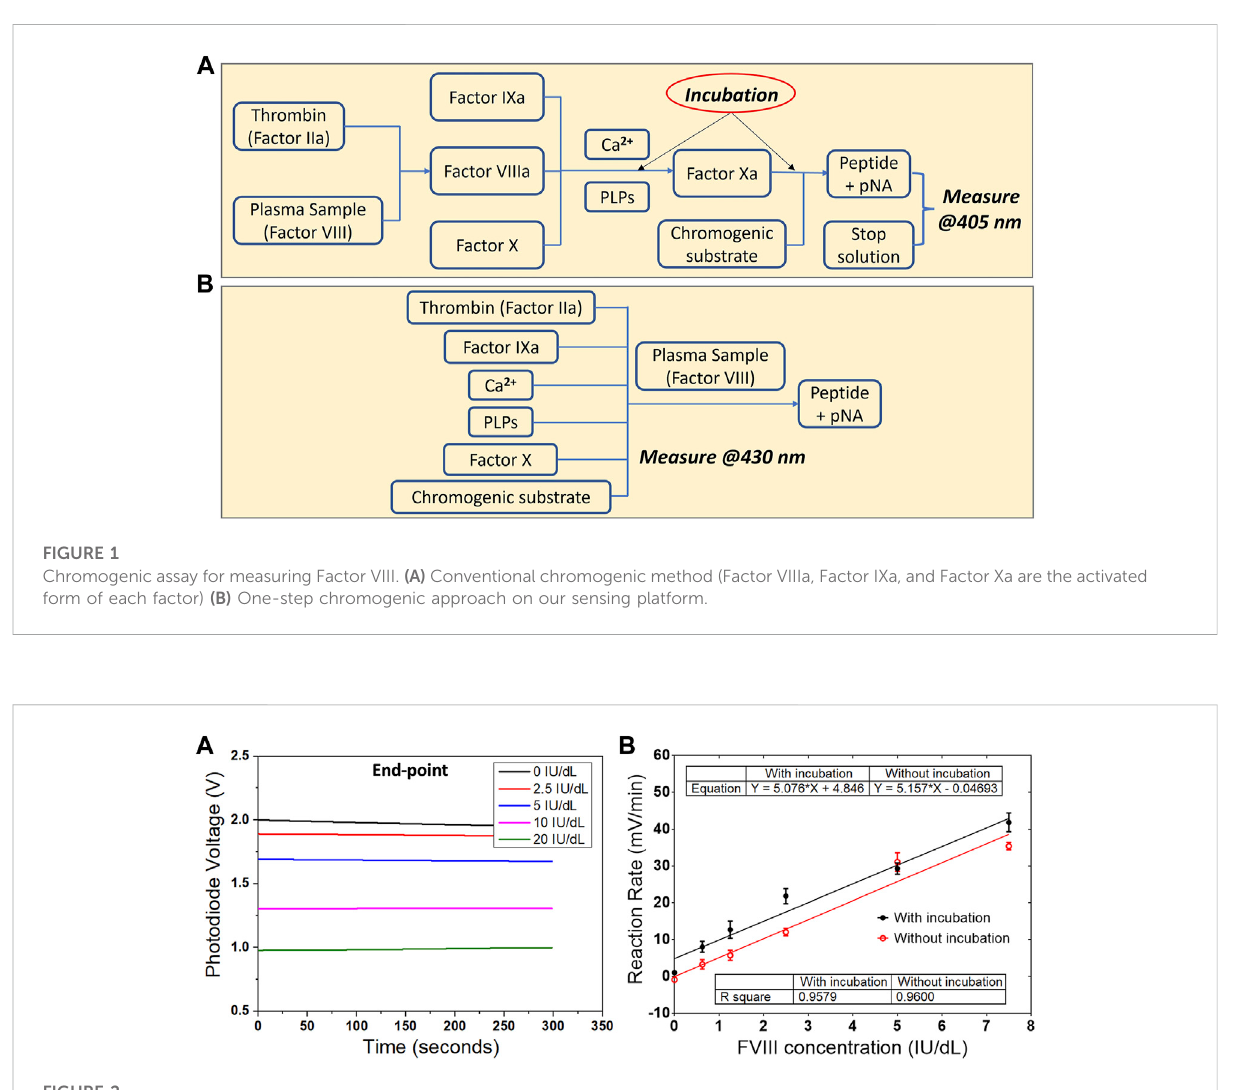
FIGURE 2 Resultsfrombothconventionalandone-stepchromogenicassay. (A) Reactioncurvesfromtheconventionalassay,whichrecordtheend-point values from fi ve different concentrations of Factor VIII. (B) Comparison of the reaction rates between the measurements with and without the incubation step. Data are the mean ± SEM with three repeated